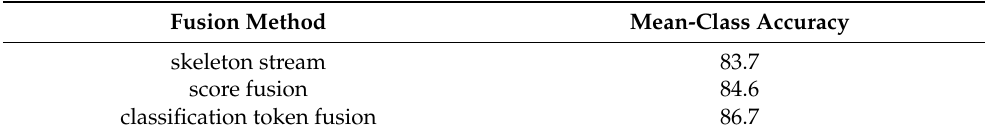
Table 3. The different fusion methods for RGBSfomer. We report the mean-class on the FineGym99 dataset. Units are in %.